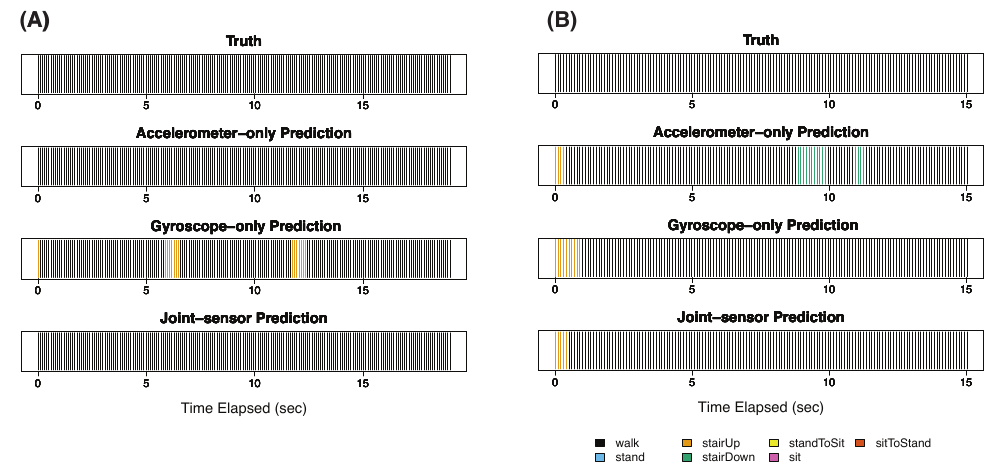
Figure 4. Step 3 for participant 3: normal and fast walking. This figure presents the results of participant 3 during step 3 for normal-paced walking Panel ( A ) and fast-paced walking Panel ( B ).